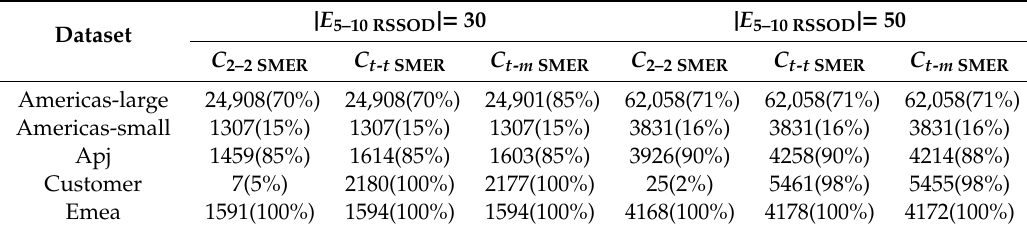
Table 10. Results of SMER constructed from 5–10